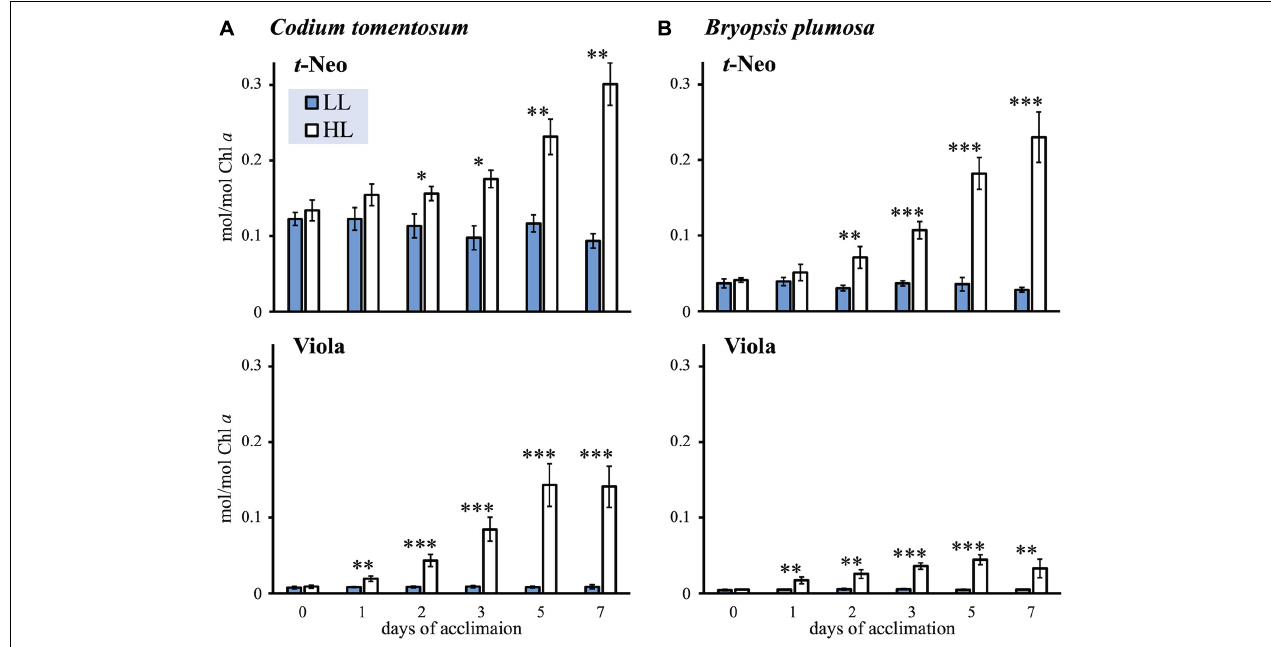
FIGURE 3 | Relative content of pigments t -Neo and Viola (mean pigment to Chl a ratio ± SD; n = 5) in low light (LL) and high light (HL) macroalgae during 7 days of light acclimation. (A) Codium tomentosum ; (B) Bryopsis plumosa. Asterisks indicate significant differences between LL and HL at each time point ( t -test): ∗ p < 0.05; ∗∗ p < 0.01; ∗∗∗ p <